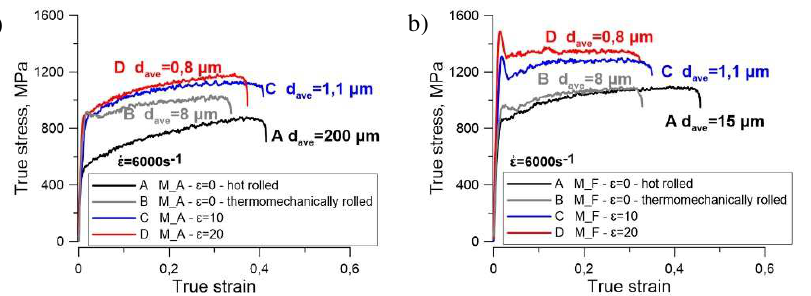
Fig.2. Comparison of the stress-strain curves obtained in the dynamic compression tests of microalloyed austenite (M_A) -a) and microalloyed ferrite (M_F) -b) as a function of the microstructure state and refinement. The symbol e represents the total strain applied during the MaxStrain